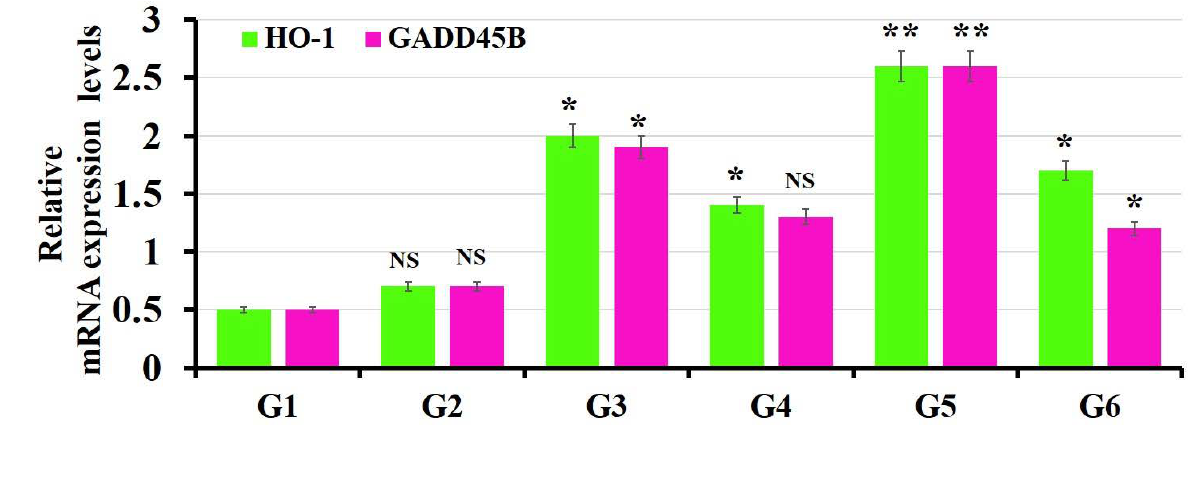
Figure 9. Effect of both MOLE and Encap. MOLE on the expression levels of HO-1 and Gadd45b in BPA—Exposed versus normal rats. G1: control. G2: BPA. G3: MOLE. G4: MOLE-BPA. G5: Encap. MOLE. G6: Encap. MOLE-BPA. The data are shown as * p < 0.05 ** p < 0.01 and *** p < 0.001.